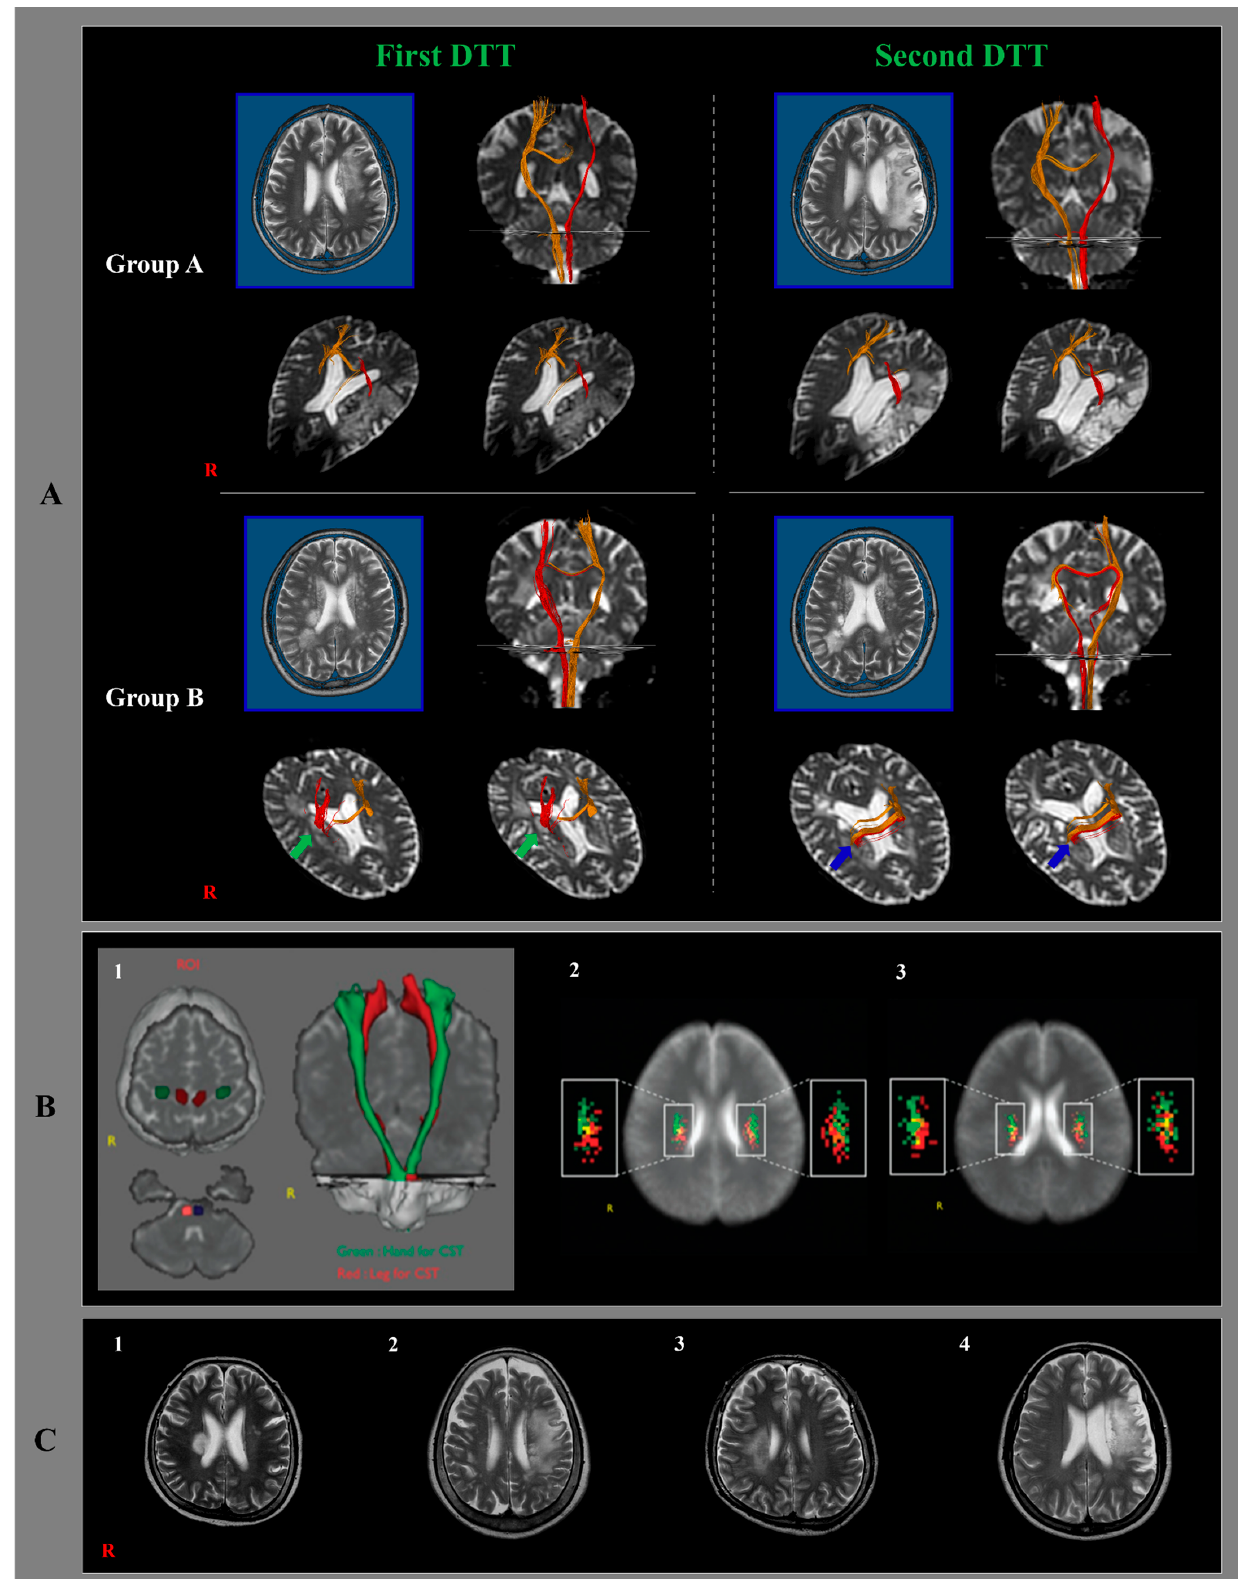
Figure 1. ( A ): Classification of diffusion tensor tractography (DTT) for the integrity of the ipsilesional corticospinal tract (CST) (red color) of the representative patients of each group. T2-weighted